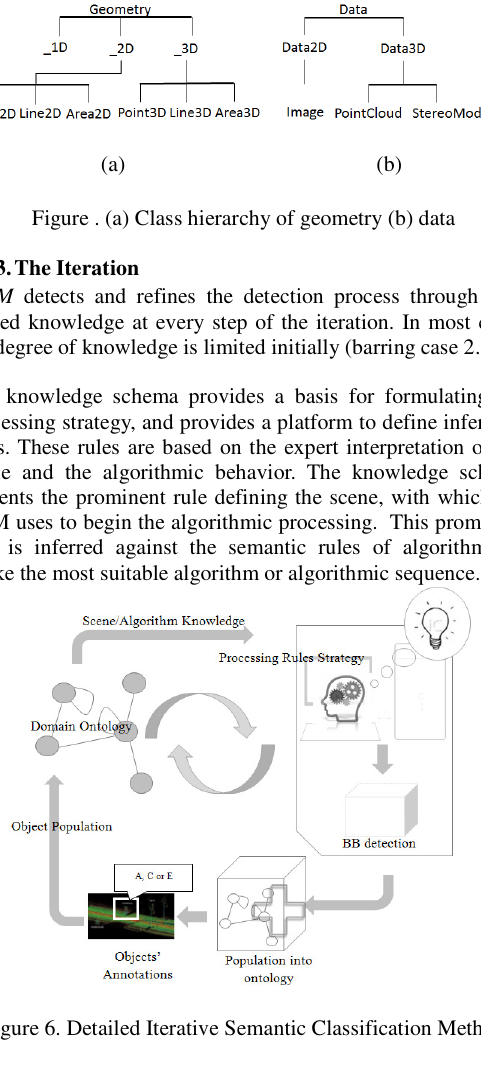
Figure . Taxonomical hierarchical semantics of class DomainConcept (scene Deutsche Bahn)